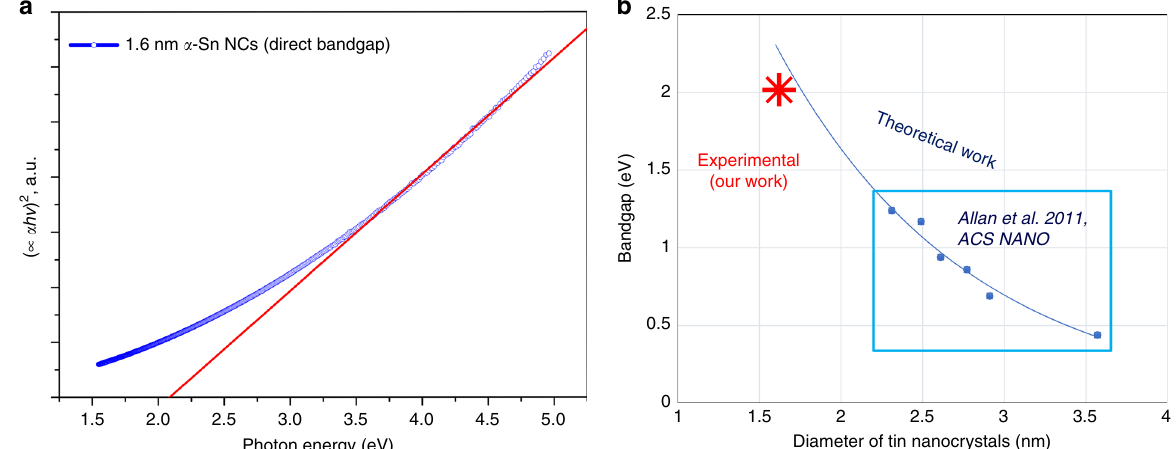
Fig. 4 Quantum con fi nement induced bandgap widening in tin (Sn) nanocrystals (NCs). a Tauc plot of 1.6 nm Sn NCs and linear fi t which estimates the bandgap to be 2.2 eV; as per Tauc plot of direct semiconductors, C ’ is the proportionality constant, α is the absorption coef fi cient, h ν is the energy ( h is Planck ’ s constant and ν is the frequency). b Bandgap values (blue dots) for Sn NCs from theoretical calculations 26 and fi tted exponential curve (blue line). The red star corresponds to our experimental result